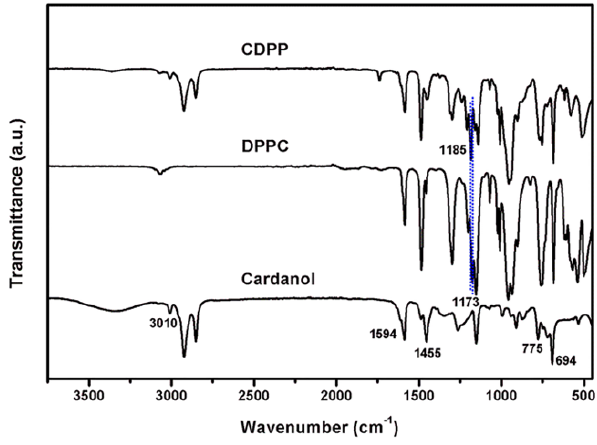
Figure 3. FT ‐ IR spectra of cardanol, DPPC, and CDPP. Figure 3. FT-IR spectra of cardanol, DPPC, and